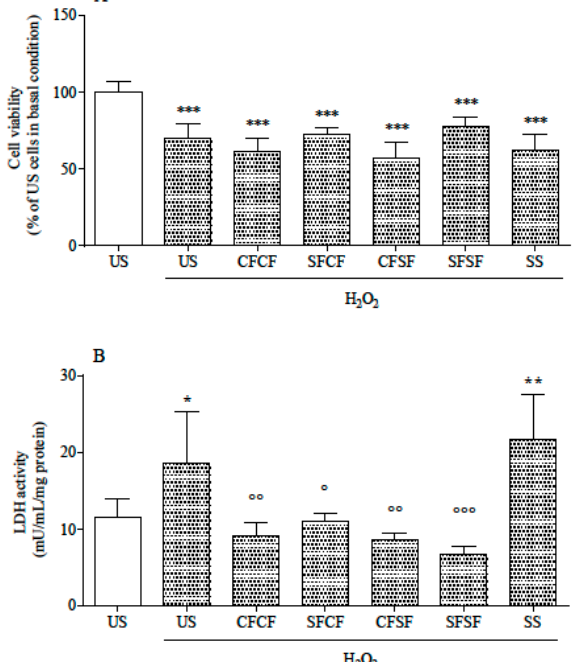
Figure 2. Cell viability ( A ) and lactate dehydrogenase (LDH) release ( B ) in un-supplemented (US) and supplemented cells. Cell viability (panel A) is expressed as % of the viability of US, not stressed cells (assigned as 100%). LDH leakage (panel B) is expressed as mU/mL/mg protein. All data are means ± SD of at least six samples derived from three independent experiments. Statistical analysis was by one-way ANOVA (A and B: p < 0.001) using Dunnet’s post-hoc test to compare stressed to US, not stressed cells (* p < 0.05; ** p < 0.01; *** p < 0.001), and supplemented stressed cells to US stressed ones ( ◦ p < 0.05; ◦◦ p < 0.01; ◦◦◦ p <